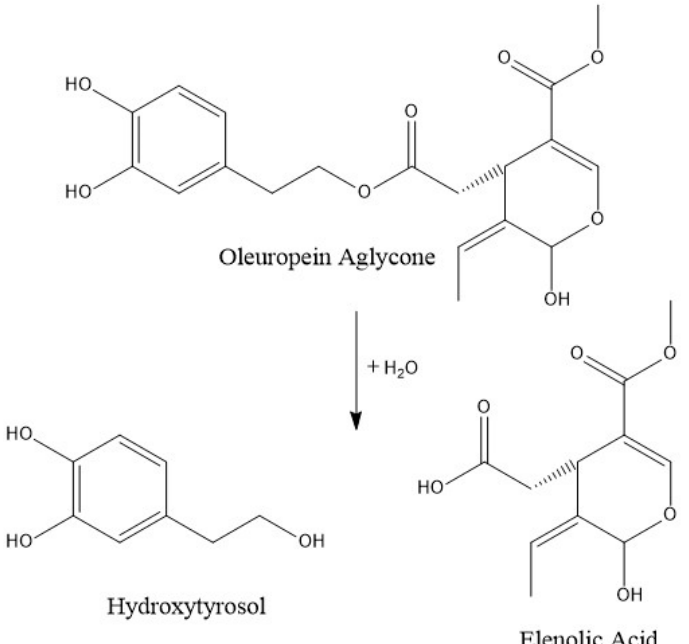
Figure 2. Normal probability plot of the sum of polyphenols.